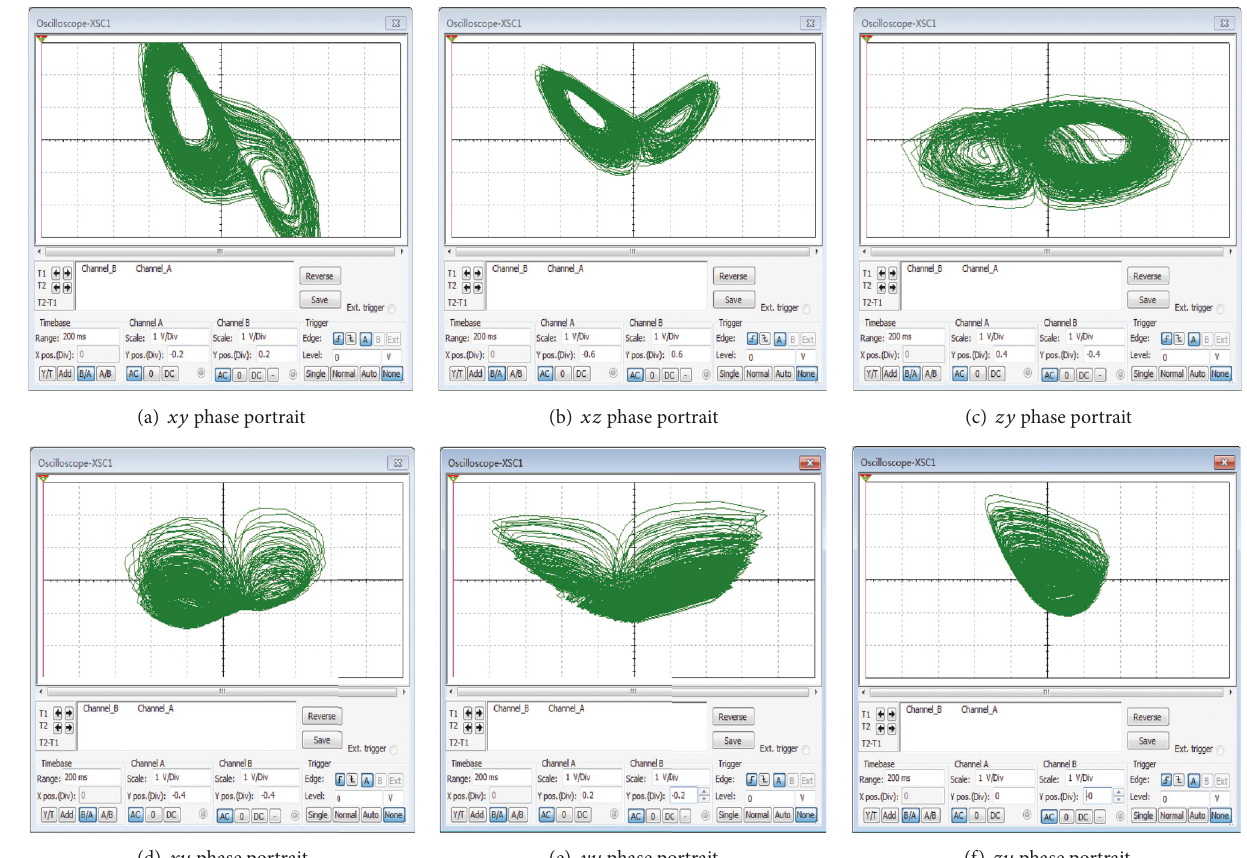
Figure 12: 𝑧 - 𝑢 - 𝑦 hyperchaotic phase portraits with